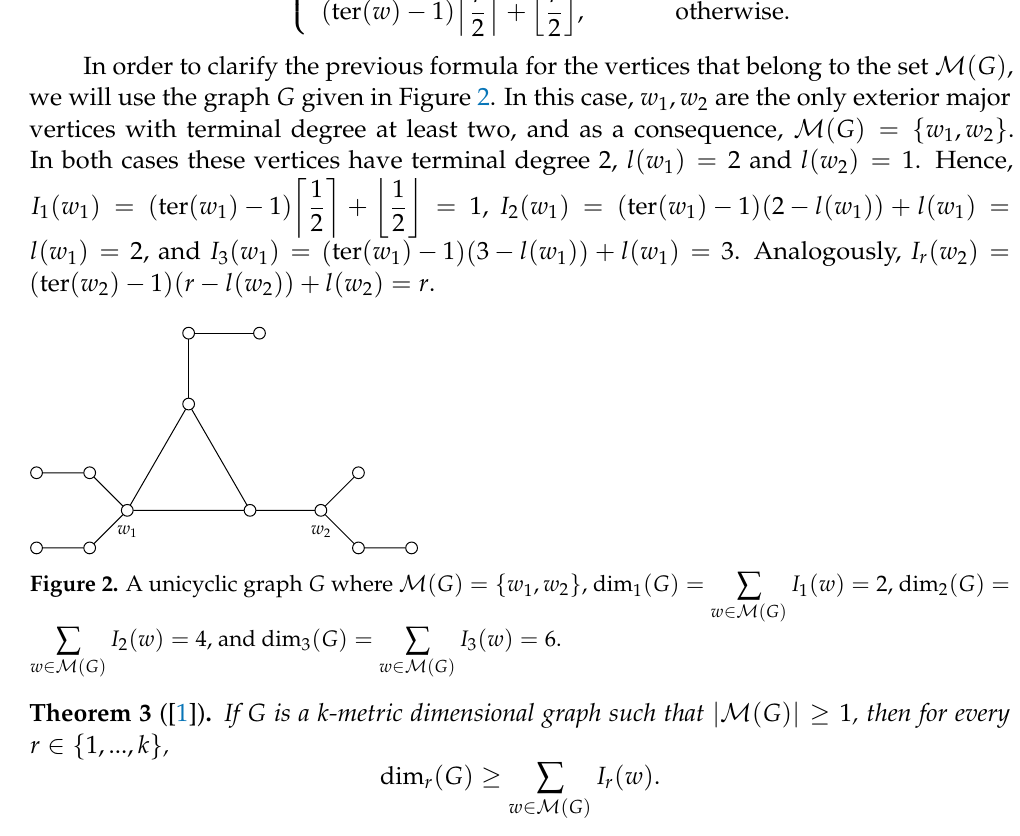
∑ I 1 ( w ) = 2, dim 2 ( G ) = w ∈M ( G )